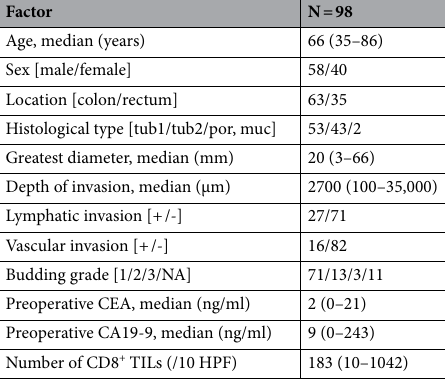
Table 1. Clinicopathologic factors of all patients. CEA carcinoembryonic antigen, CA19-9 Carbohydrate Antigen 19–9, CD cluster of differentiation, TIL tumor-infiltrating lymphocytes, HPS high-power